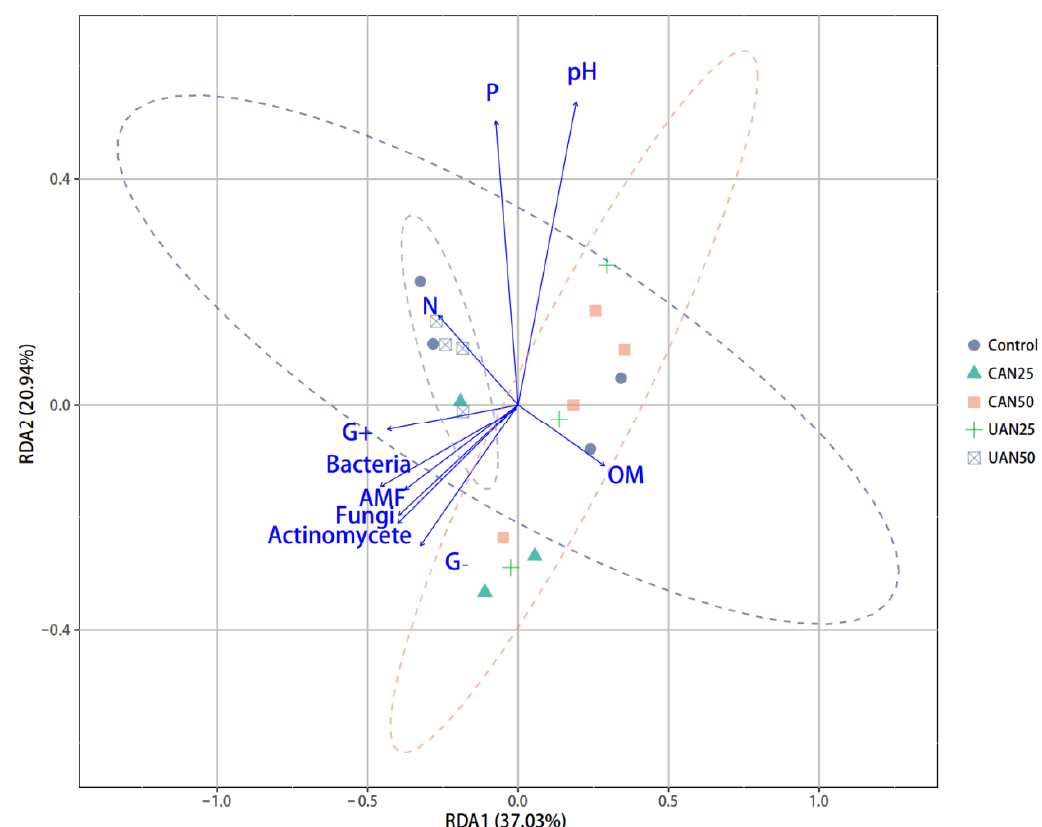
Figure 5. Redundancy analysis (RDA) illustrating the correlations between seed density and species richness in soil seed banks and environmental factors as affected by N-addition treatments. OM: organic matter; N: nitrogen; P: phosphorus; AMF: arbuscular mycorrhizal fungi; G+: Gram-positive bacteria; G-: Gram-negative bacteria. Treatments are described in Table 1 and in the text. Table 2. Soil chemical and microbial properties as affected by N-addition treatments across various canopy and understory of the forest ecosystem.